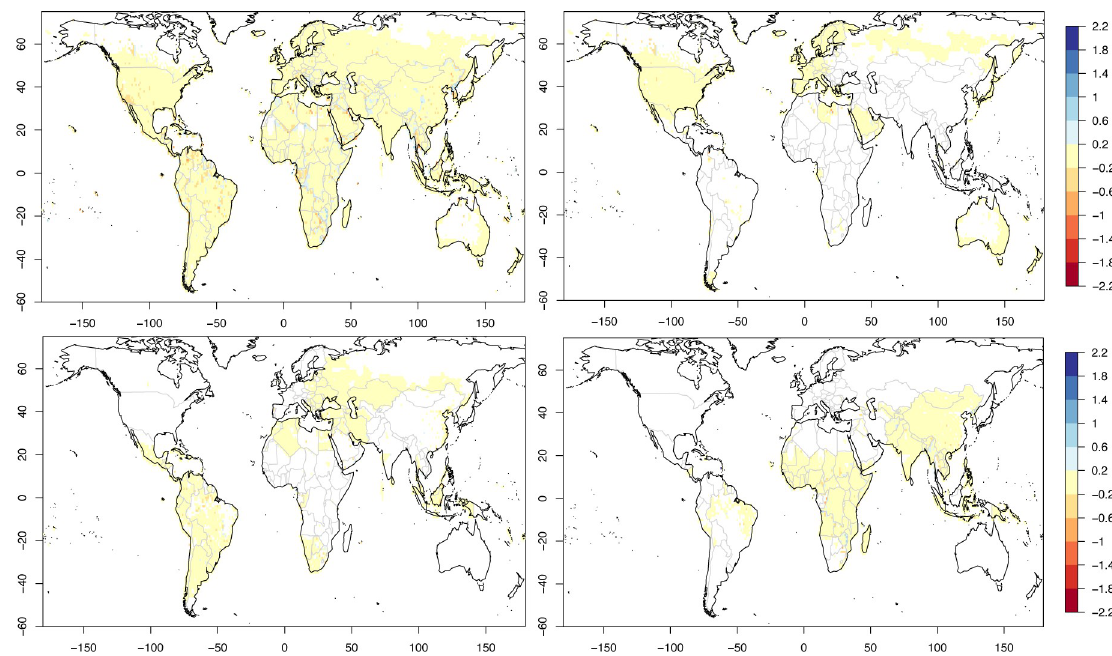
Fig 6. Difference between predicted and observed GCP-PC. Difference between predicted (using the top 10 predictors) and observed GCP-PC, namely ( f –GCP-PC) in Eq (1). Top left: all grid points. Top right: top tercile of GCP-PC. Bottom left: middle tercile of GCP-PC. Bottom right: bottom tercile of